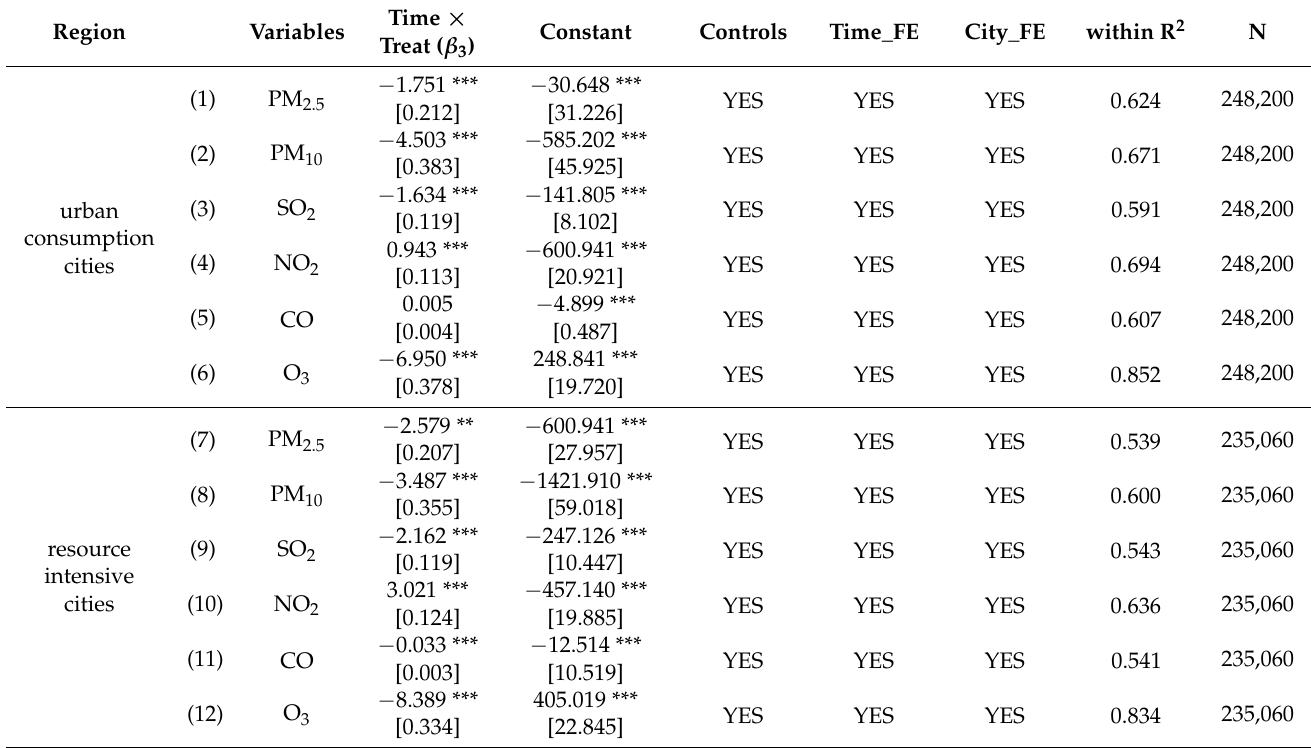
Table 3. Estimation results of the BSDW policy on air pollution in different industry type of cities.